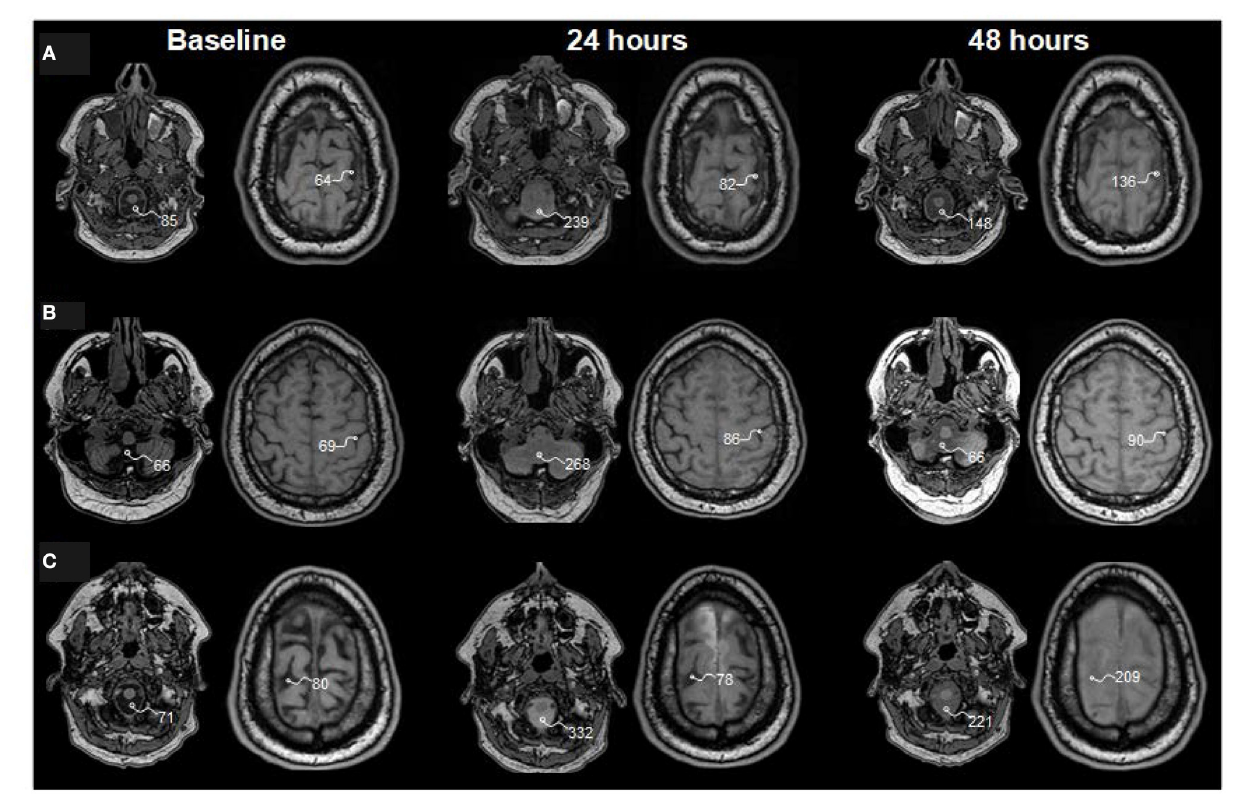
FIGURE 1 | Tracer enrichment within subarachnoid cerebrospinal fluid (CSF) spaces at baseline and 24 and 48h after intrathecal injection of gadobutrol in doses of (A) 0.10 mmol, (B) 0.25 mmol, and (C) 0.50 mmol. Reconstructed axial T1 weighted images from three patients with idiopathic normal pressure hydrocephalus (iNPH) who were examined in a 1.5T MRI scanner. The T1 signal unit values within regions of interest in cisterna magna and at the vertex are shown and exemplify the strongest increase of T1 signal units after intrathecal gadobutrol in the dose of 0.5 mmol. For analysis of change in T1 signal units, we further normalize the T1 signal units against a region of interest placed within the posterior part of the orbit (not shown here), which provides normalized signal units ( 37). See Tables 3 , 4